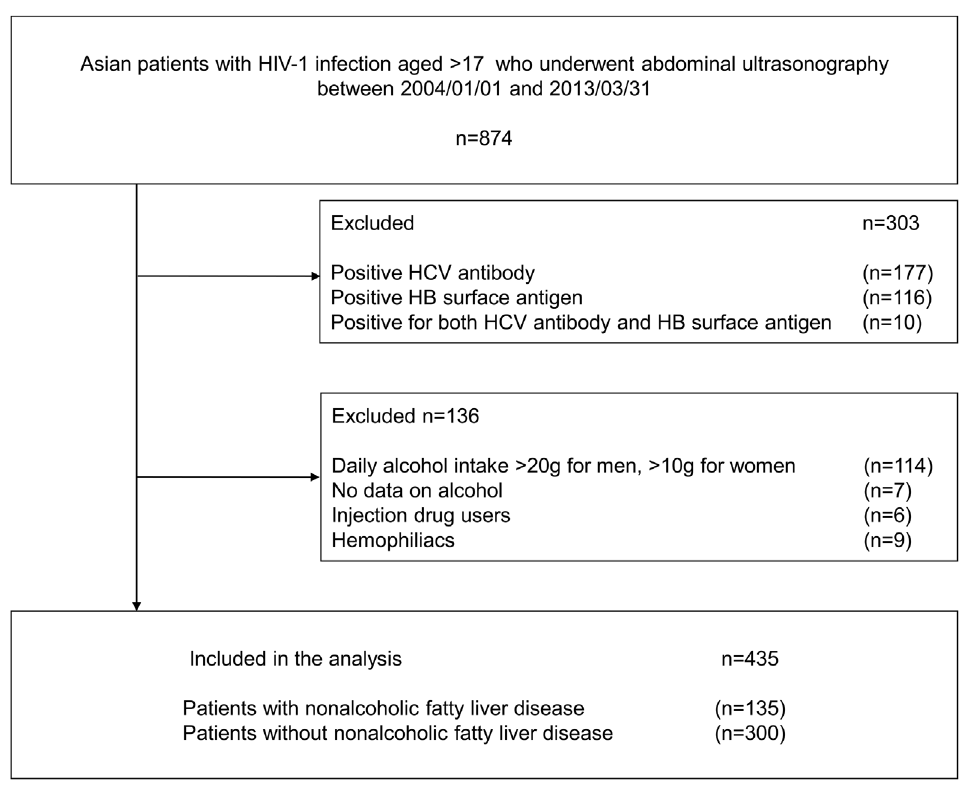
Figure 1. Patient enrollment process.